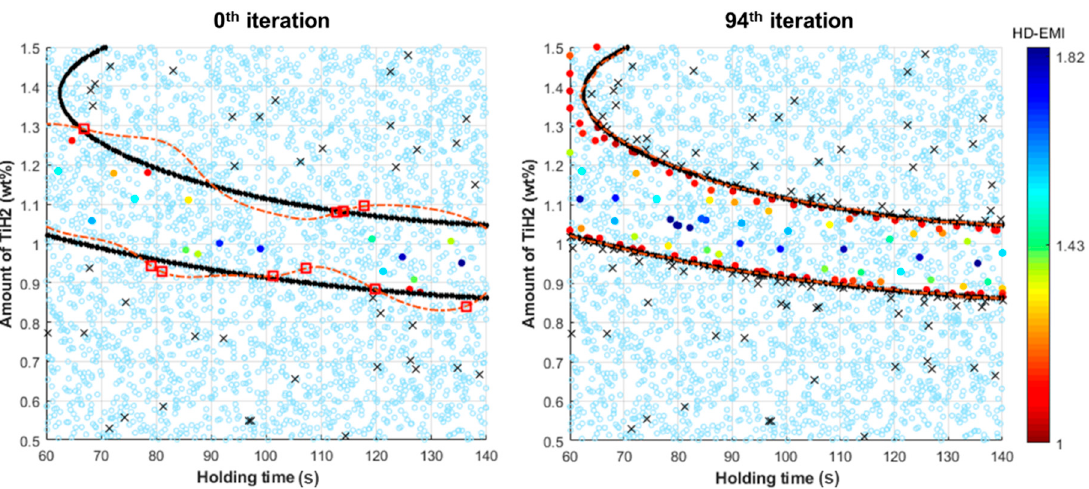
Figure 10. Feasible region at processing